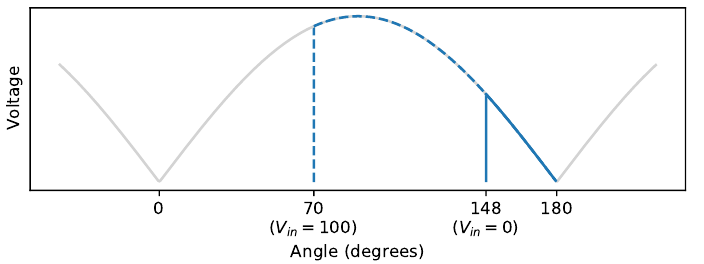
Figure 2. Setup voltage V in determines the period during which the circuit is completed by the thyristor, passing the